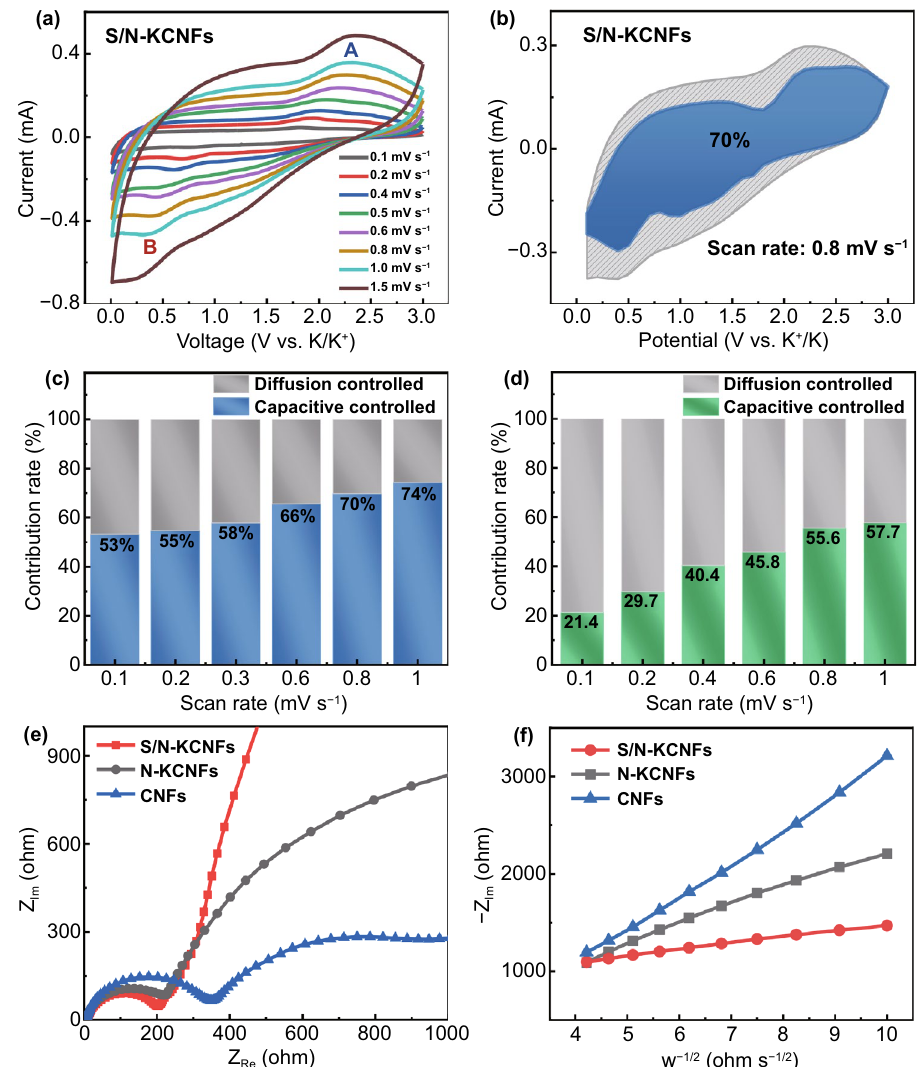
Fig. 7 a CV curve of S/N-KCNFs at different scanning rates in the range of 0.1–1.5 mV s −1 ; b the CV curves of S/N-KCNFs show pseudoca- pacitance and diffusion-contribution at 0.8 mV s −1 ; the relative contributions of capacitance and diffusion-controlled charge storage of c S/N- KCNFs and d N-KCNFs at different scan rates are analyzed; e electrochemical impedance spectroscopy (EIS) (Nyquist plots), and f the slope Z corresponding to the linear relationship between Im and ω of S/N-KCNFs, N-KCNFs and CNFs before